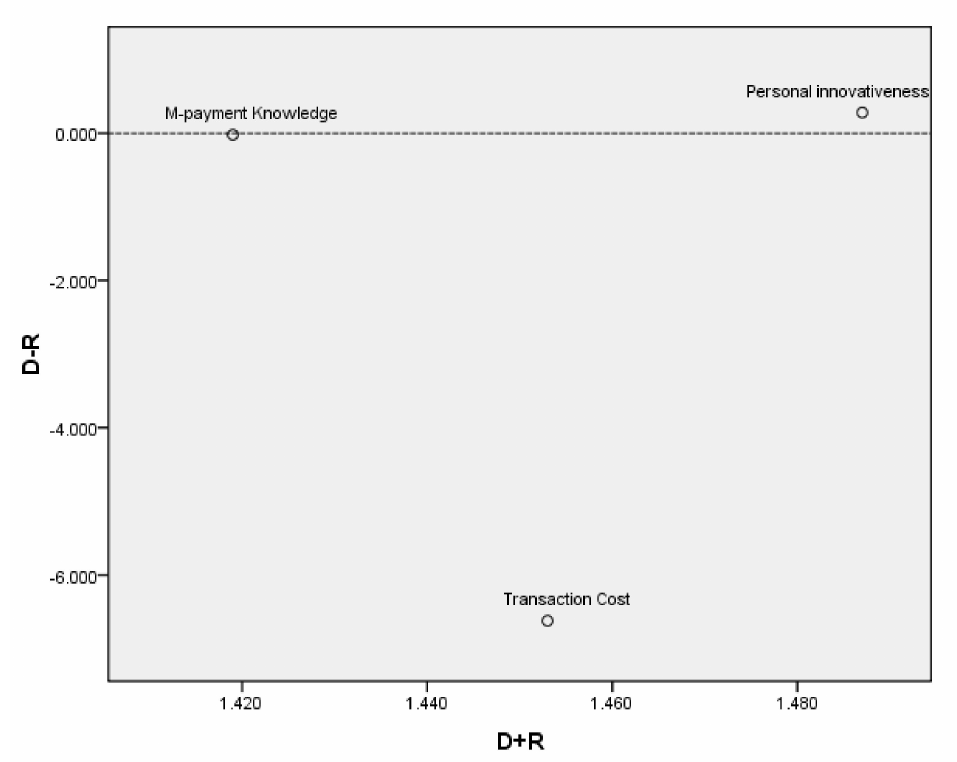
Figure 3. Graph of causal relationships between the second tier criteria of the individual measurement.